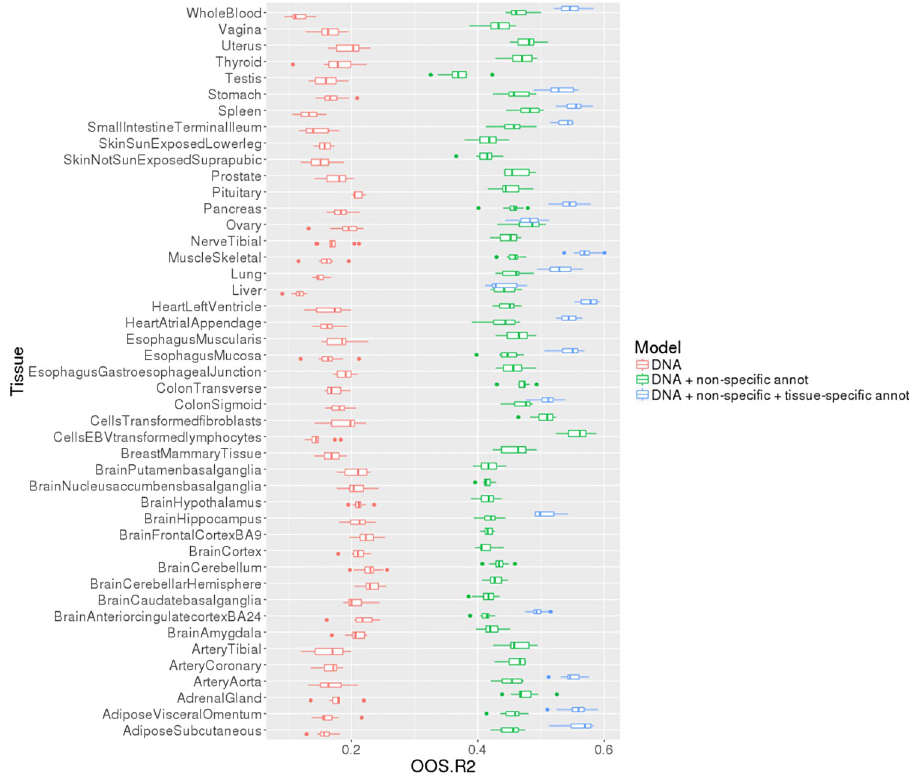
Fig 1. Incorporating genomic and epigenetic annotations improves the performance of peaBrain to predict the normalized mean abundance across all GTEx tissues. The 4kbps promoter sequence, when annotated with tissue specific annotations, is sufficient to predict the majority of variance in mean expression in most tissues, ordered alphabetically from the x-axis. The boxplots highlight the distribution of the 10-folds used to cross-validate model performance. Prediction using regularized linear models performs considerably worse (10-fold cross-validated r 2 < 0; S1 Text ). Abbreviations: OSS.R2, out-of-sample r 2